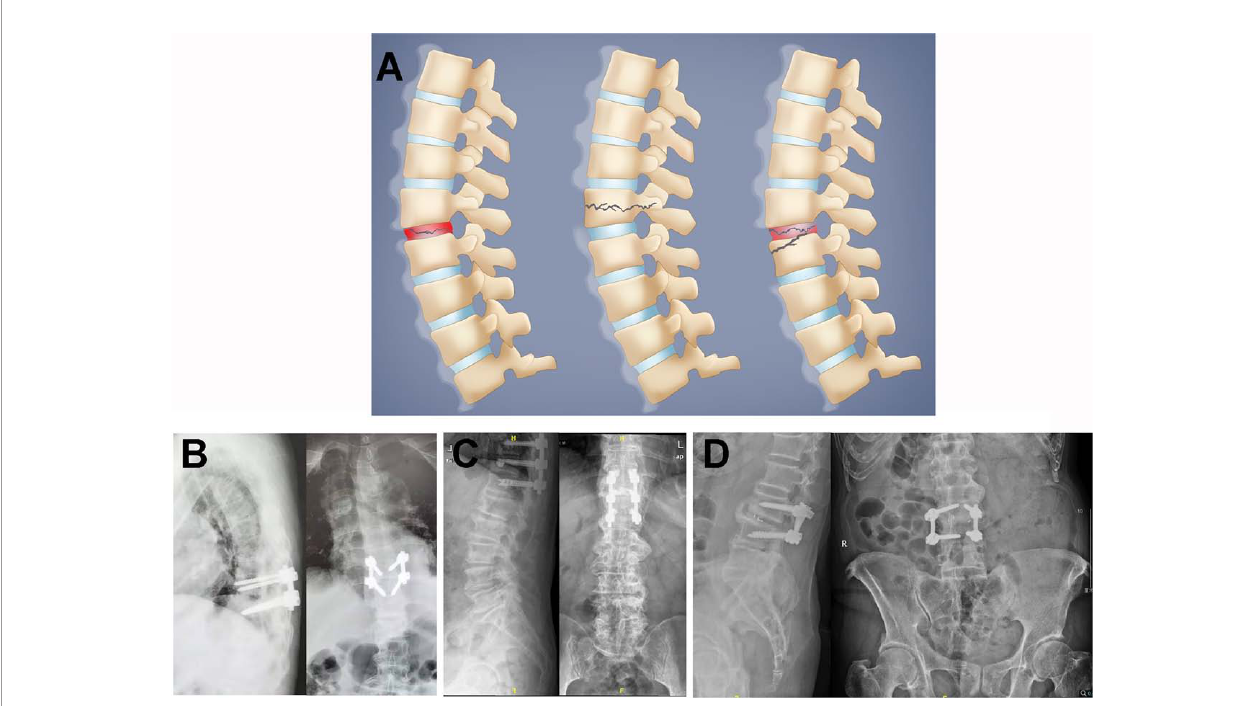
FIGURE 2 | (A) Schematic illustration of Andersson-like lesions (ALLs) in diffuse idiopathic skeletal hyperostosis (DISH). The ALLs were classi fi ed as transdiscal ( left ), transvertebral ( middle ), or discovertebral ( right ) lesions in the DISH spine. (B – D) Postoperative radiographs for case 1 (B) , case 3 (C) , and case 4 (D) . Case 2 underwent conservative treatment, which included pharmacologic and corset interventions, due to respiratory and circulatory